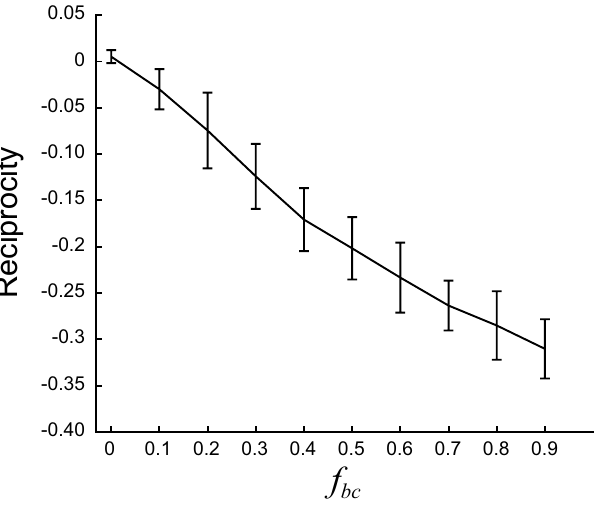
Figure 8. Relative-coding network states cause negative reciprocity. Reciprocity as a function of f bc , the fraction of bicolored nodes, in networks that follow random transition graphs. Reciprocity decreases linearly with f bc , approaching zero as f bc approaches zero. Mean ± SD are shown, n = 30 networks for each f bc . Networks were constructed with target FR = 0.5 spikes/ time step, and with the same number of neurons and network firing states as T + F networks constructed with τ = 7 and f r = 4